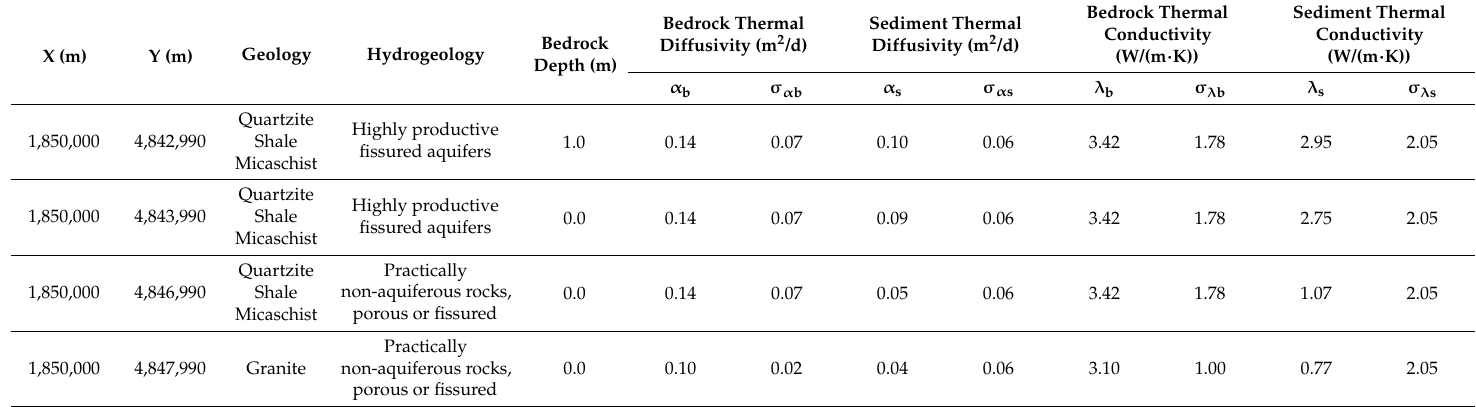
Table 10. Database of data aimed to define ground temperature evolution—first part (example grid nodes located in Andorra).